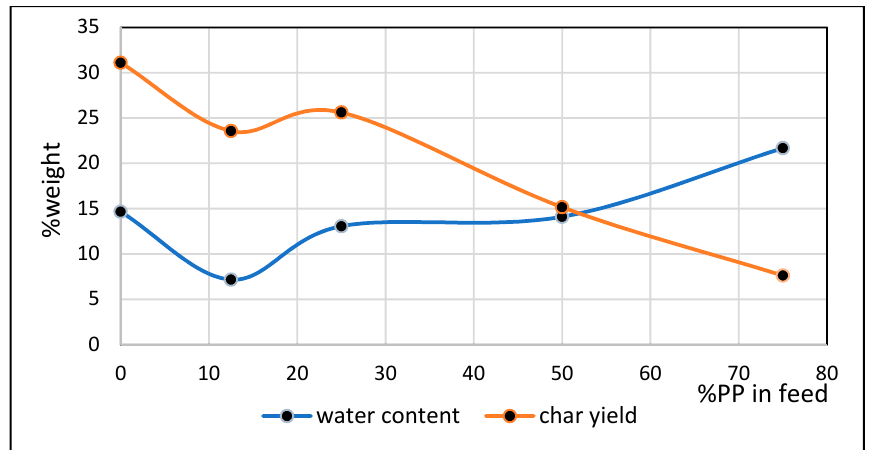
Figure 10. Average water content in polar fractions of bio-oil.